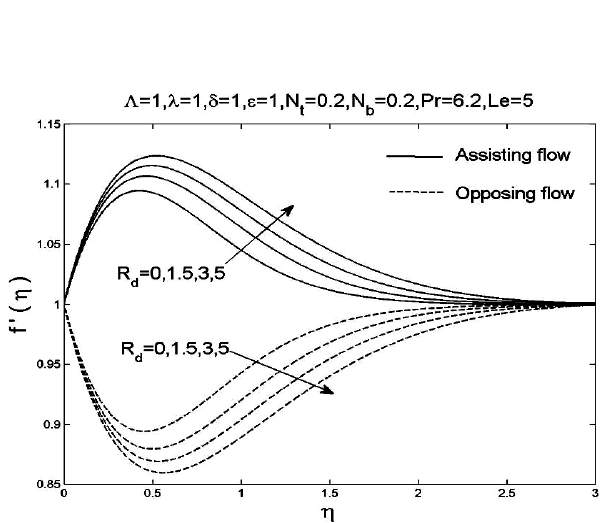
Fig. 7. The effect of the Brownian motion parameter Nb on the velocity profiles ( ) f η′